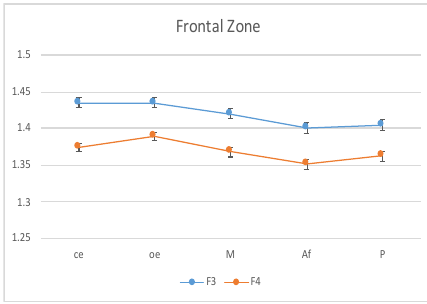
Figure 3. Fractal dimension values in the different types of EEG (closed eyes (ce), open (oe), Afghanistan type conduction (Af), Mali type conduction (M), and training track (P)) in the occipital area (left) and temporal zone (right).